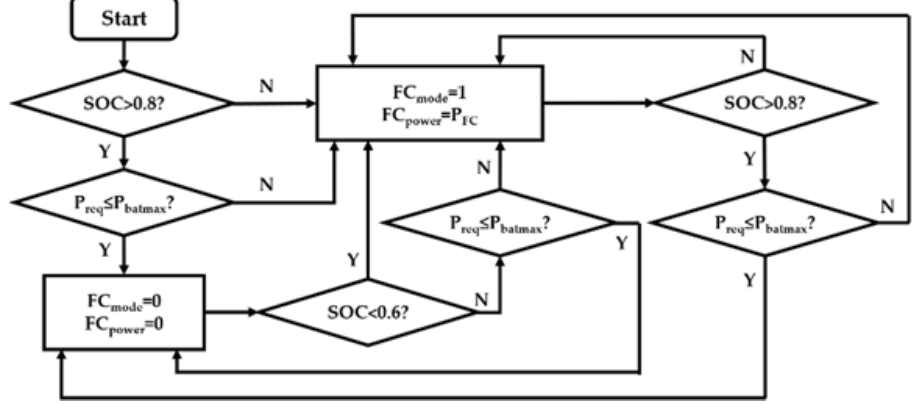
Figure 7. Flow chart of the switch control